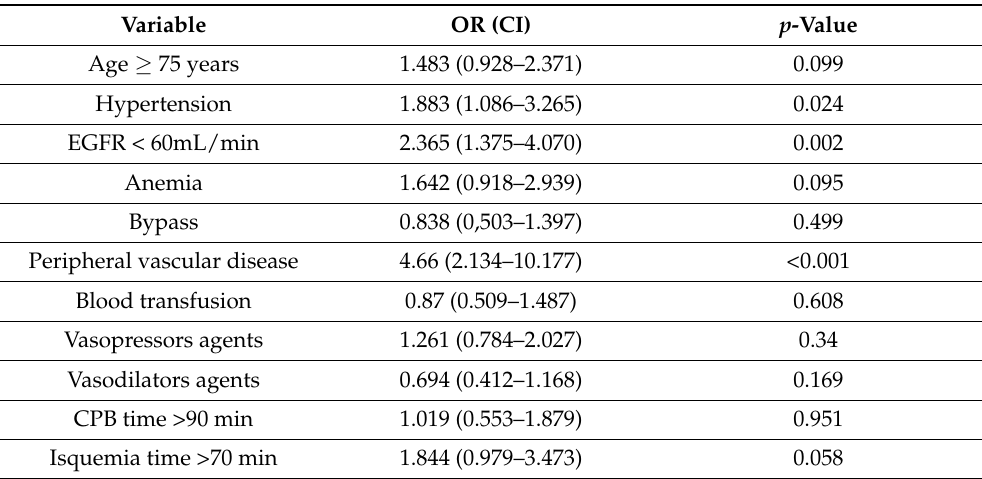
Table 5. Multivariate analysis of risk factors associated with cardiac surgery-associated acute kidney injury.